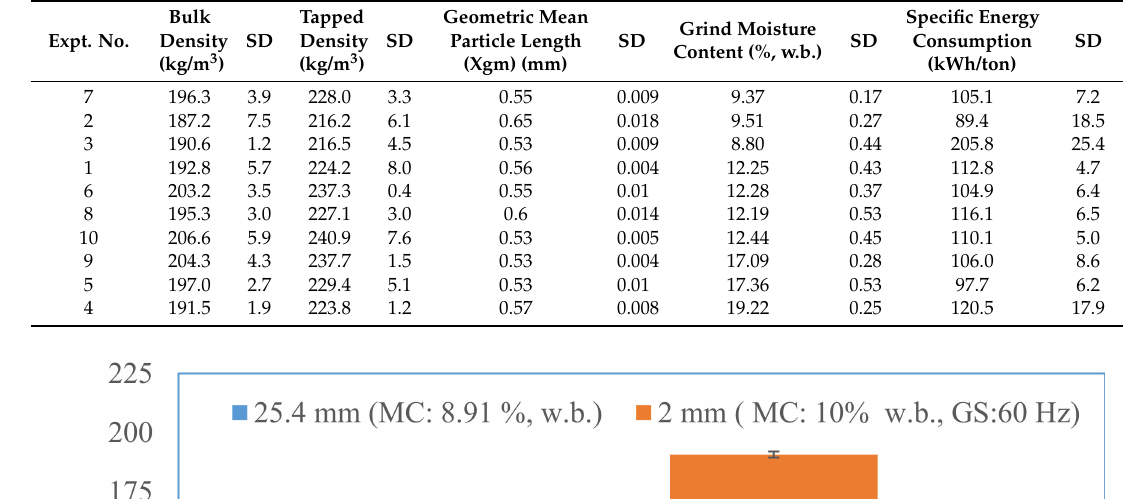
Table 3. The experimental data based on the central composite design.